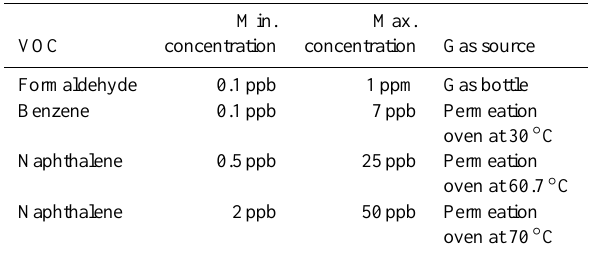
Table 2. Gas specifications.